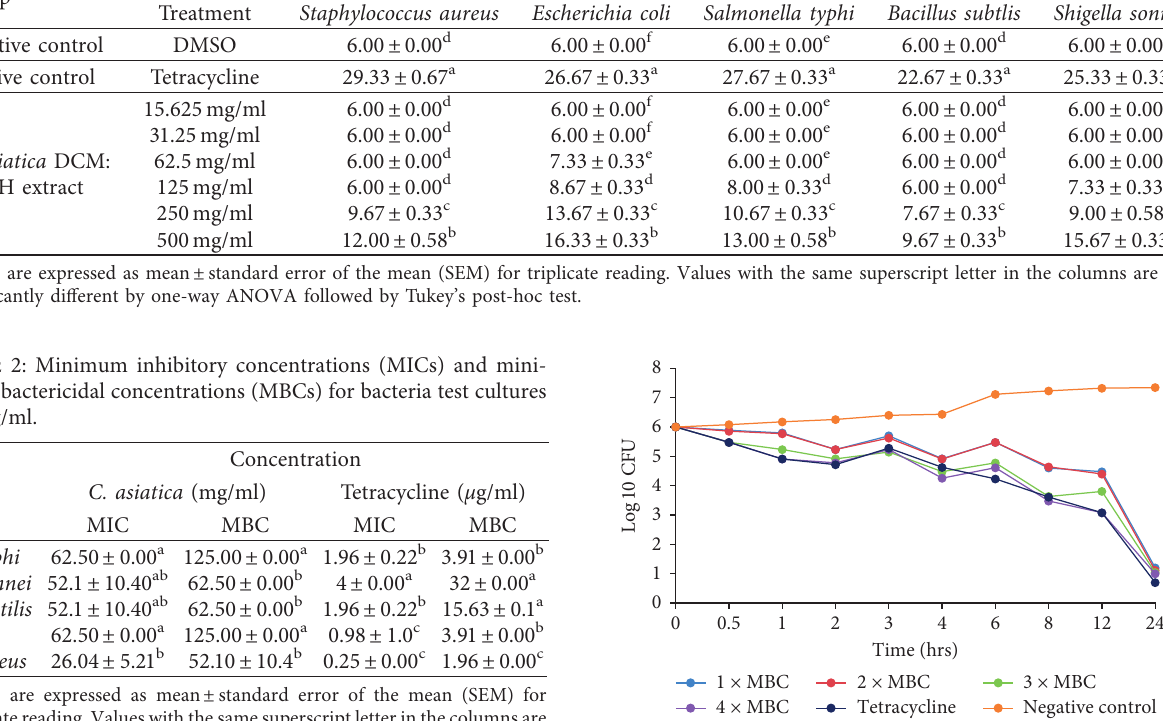
Figure 3: Time-kill kinetics activities of the dichloromethane: methanolic extract of C. asiatica against S. typhi .